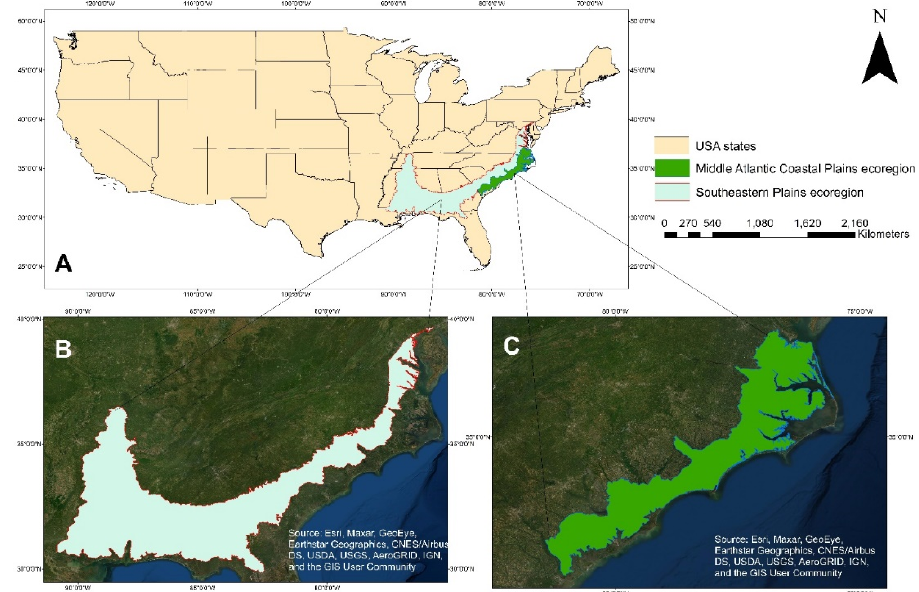
Figure 1. Study area in southeastern US ( A ). Southeastern Plains ecoregion ( B ). Middle Atlantic Coastal Plains ecoregion ( C ). Map coordinate system is WGS 1984. World Imagery is used as basemap in ( B , C ).